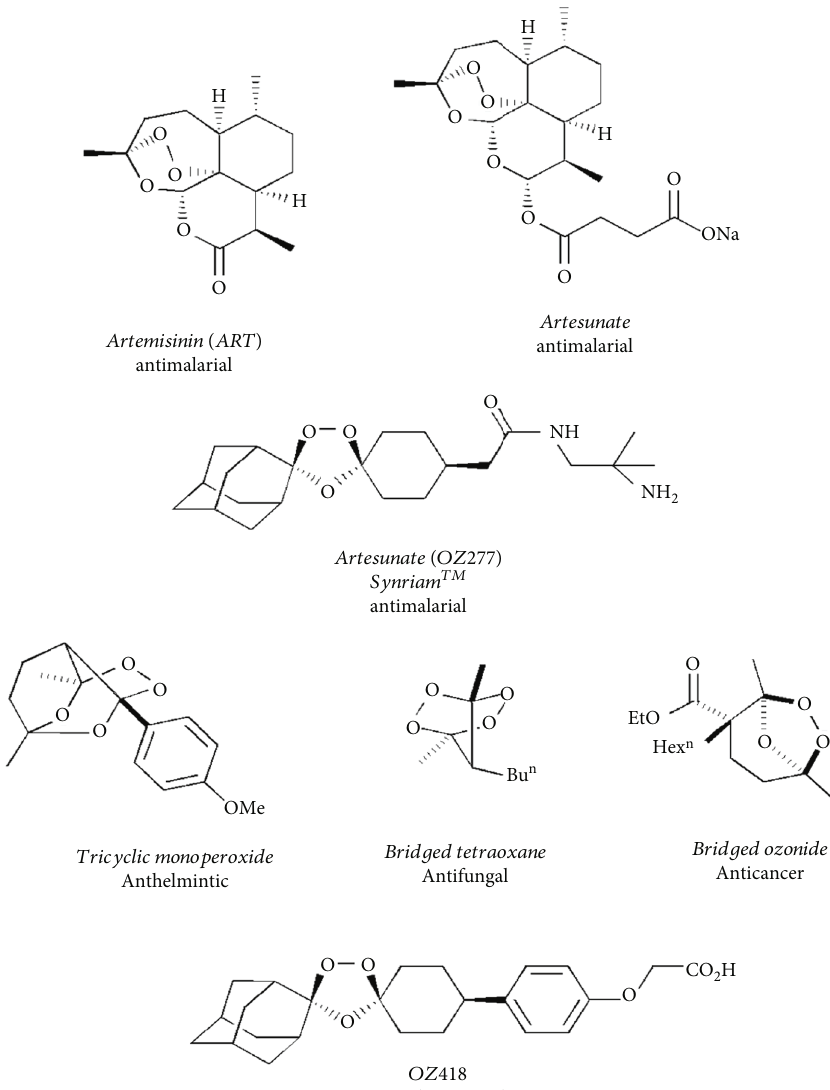
Figure 1: Biologically active peroxides of natural, semisynthetic, and synthetic origin.